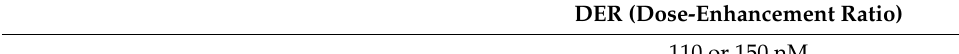
Table 2. DER analysis.